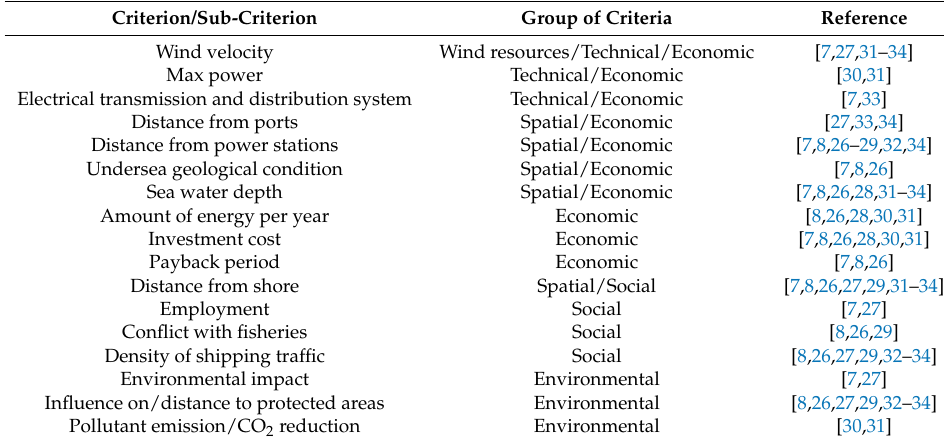
Table 2. Criteria and sub-criteria most commonly used in the problem of location selection for offshore wind/hybrid farms including sustainability